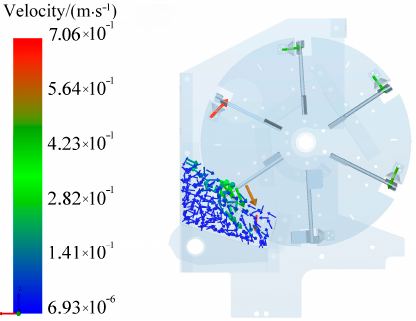
Figure 9. Garlic seed movement when the population was below 160 grains.